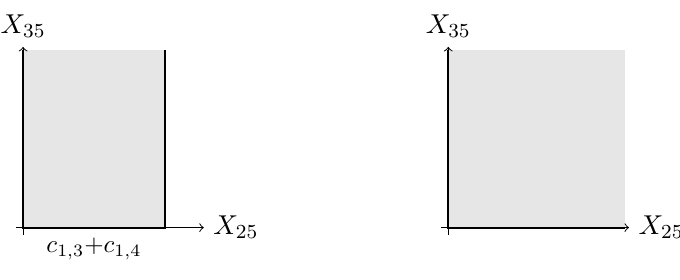
Figure 7 . Unbounded polyhedra appearing for β = (12435) and β = (13425)